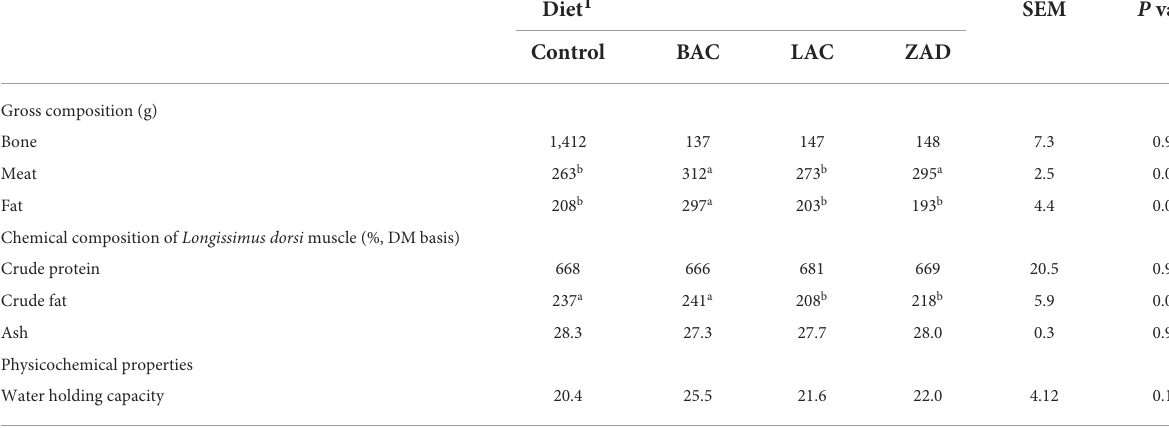
TABLE 5 Gross and chemical compositions, and physicochemical properties of carcass of growing Farafra lambs fed diets containing date palm leaves treated with different